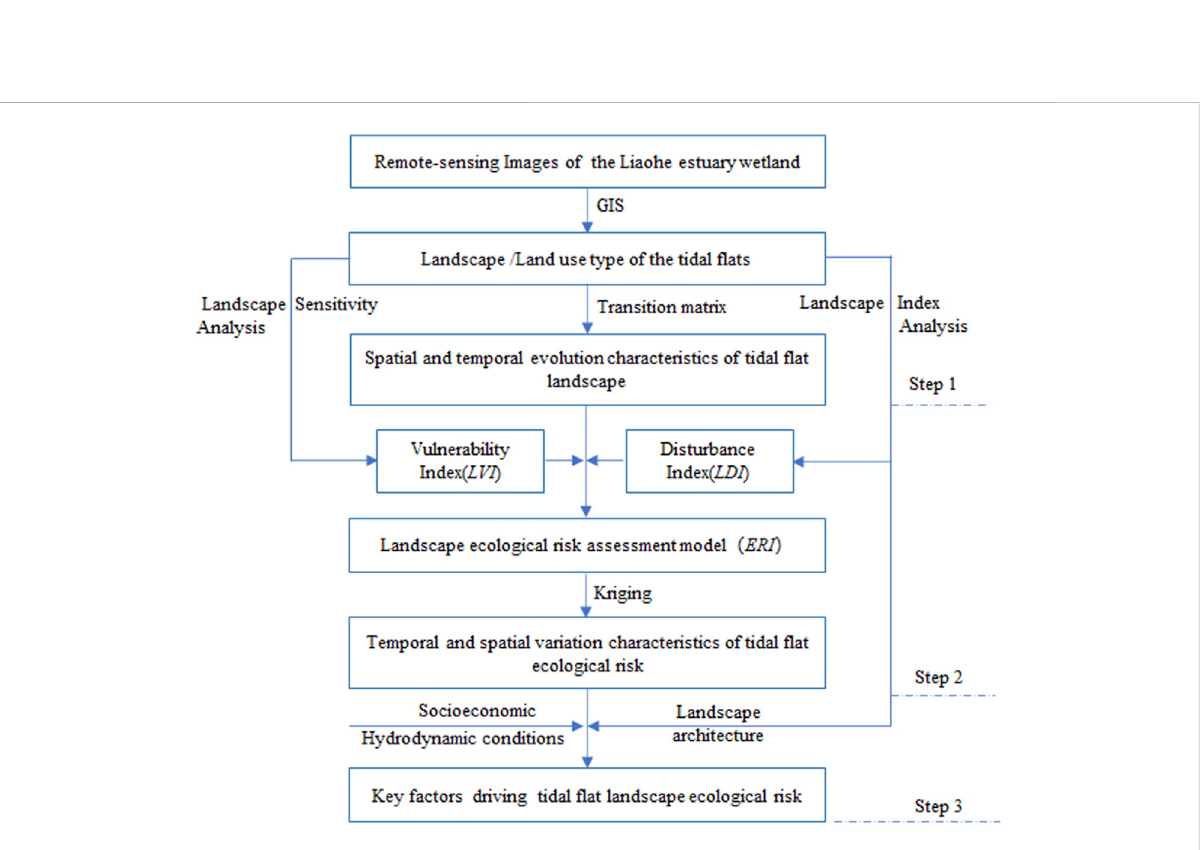
FIGURE 2 Research methods and technology fl ow